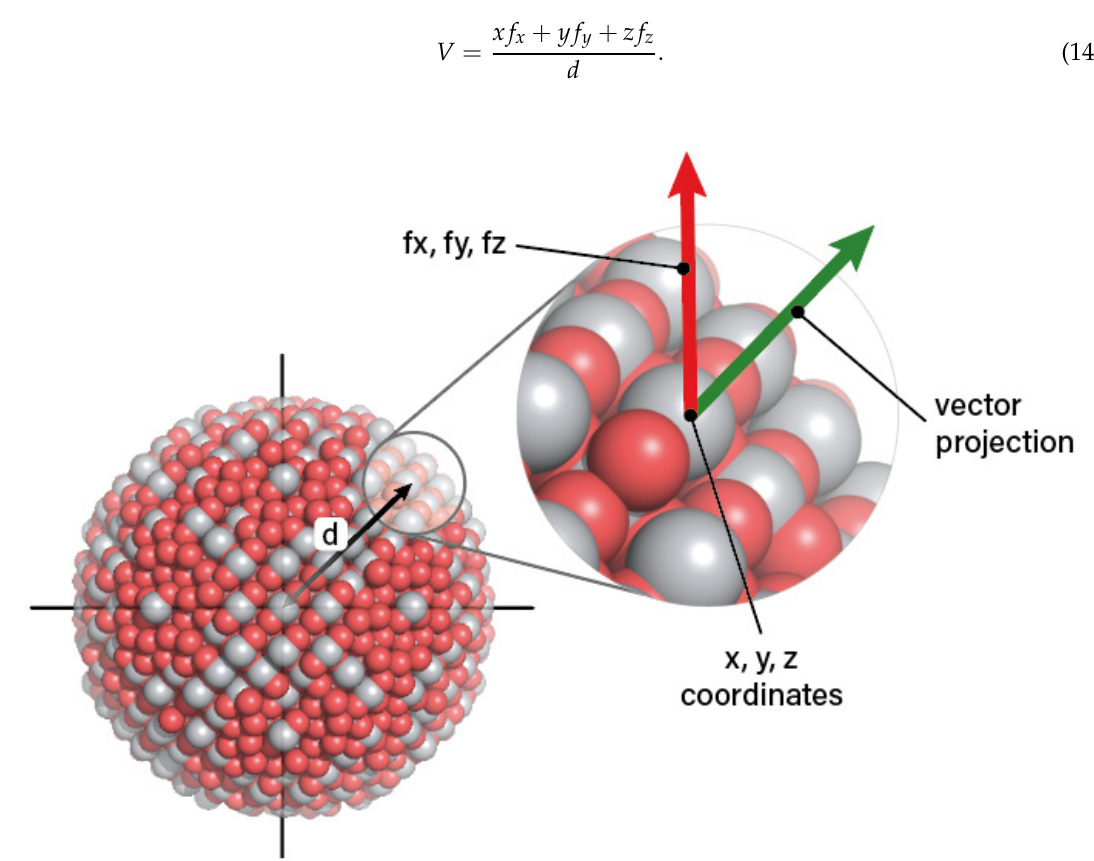
Figure 1. Normal component of the force vector of a single atom (green) in the shell region of a metal oxide (Me x O y ) nanoparticle (NP) (grey spheres: metal atoms and red spheres: oxygen atoms). The average length V of the surface normal component of force vector of all atoms in the shell region of the NP is calculated for all atoms using x , y and z coordinates of atom and f x , f y and f z components of the force vector using the formula V = (x*f x + y*f y + z*f z ) / d , where x, y and z are atom coordinates relative to the NP centre-of-mass, f x , f y and f z are the x , y and z components of atoms force vector and d is the distance of the atom from the centre of the NP.